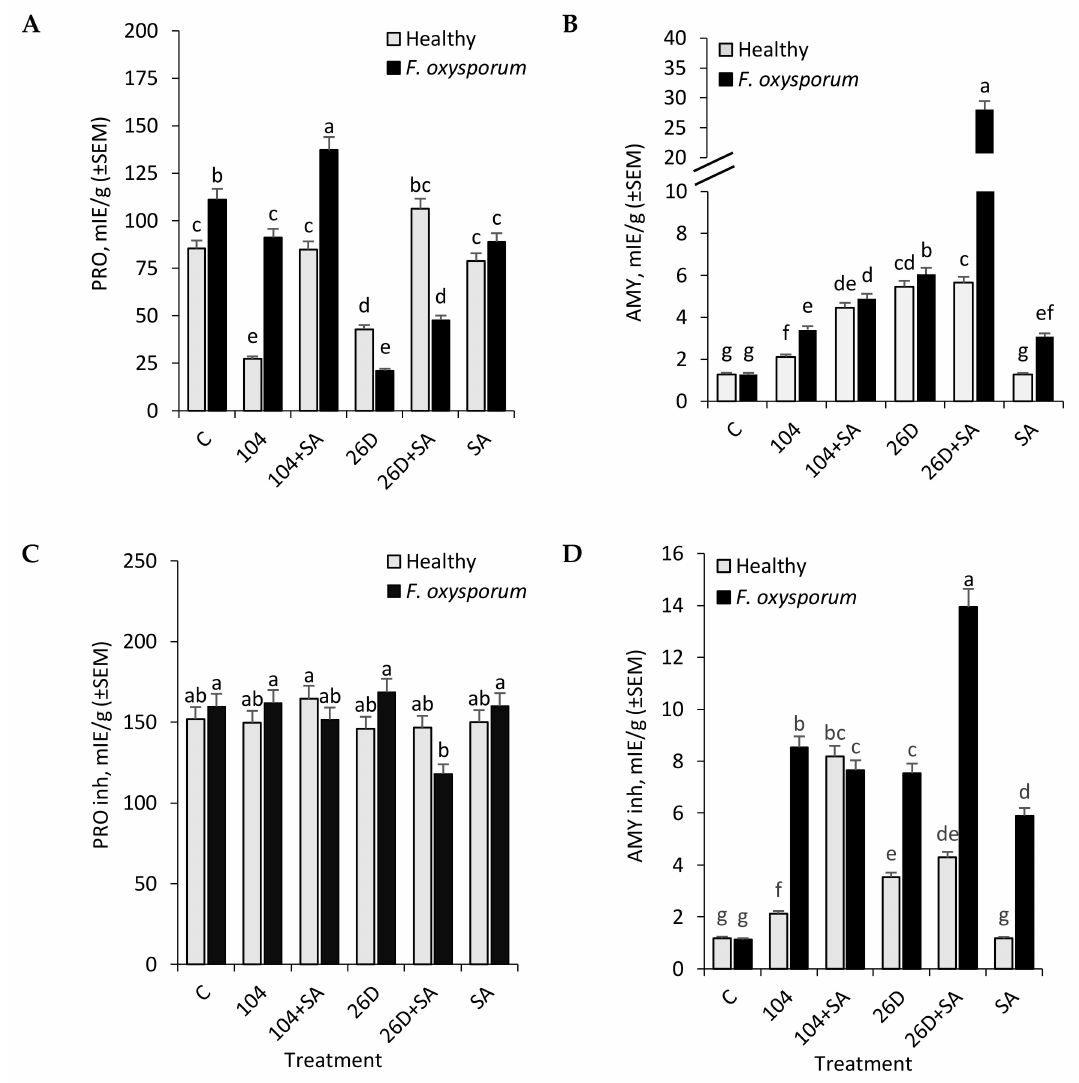
Figure 3. E ff ect of endophytic bacteria B. subtilis 10-4 (104) and B. subtilis 26D (26D), individually and in compositions with SA (104 + SA, 26D + SA), on activities of hydrolytic enzymes protease (PRO) ( A ), amylase (AMY) ( B ) and inhibitors of protease (PRO inh) ( C ) and inhibitors of amylase (AMY inh) ( D ) in F. oxysporum -infected ( F. oxysporum ) and non-infected (Healthy) potato tubers during storage (time of storage six months). The bars are the means of three repetitions ± SEM. Di ff erent letters indicate a significant di ff erence between the means at the probability level of p <